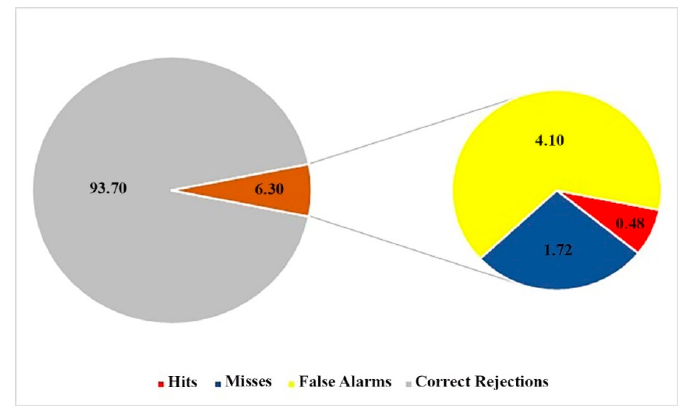
Figure 8. The figure of merit’s non-nil components (hits, misses, and false alarms) as a percentage of the spatial extent of western Tarai.